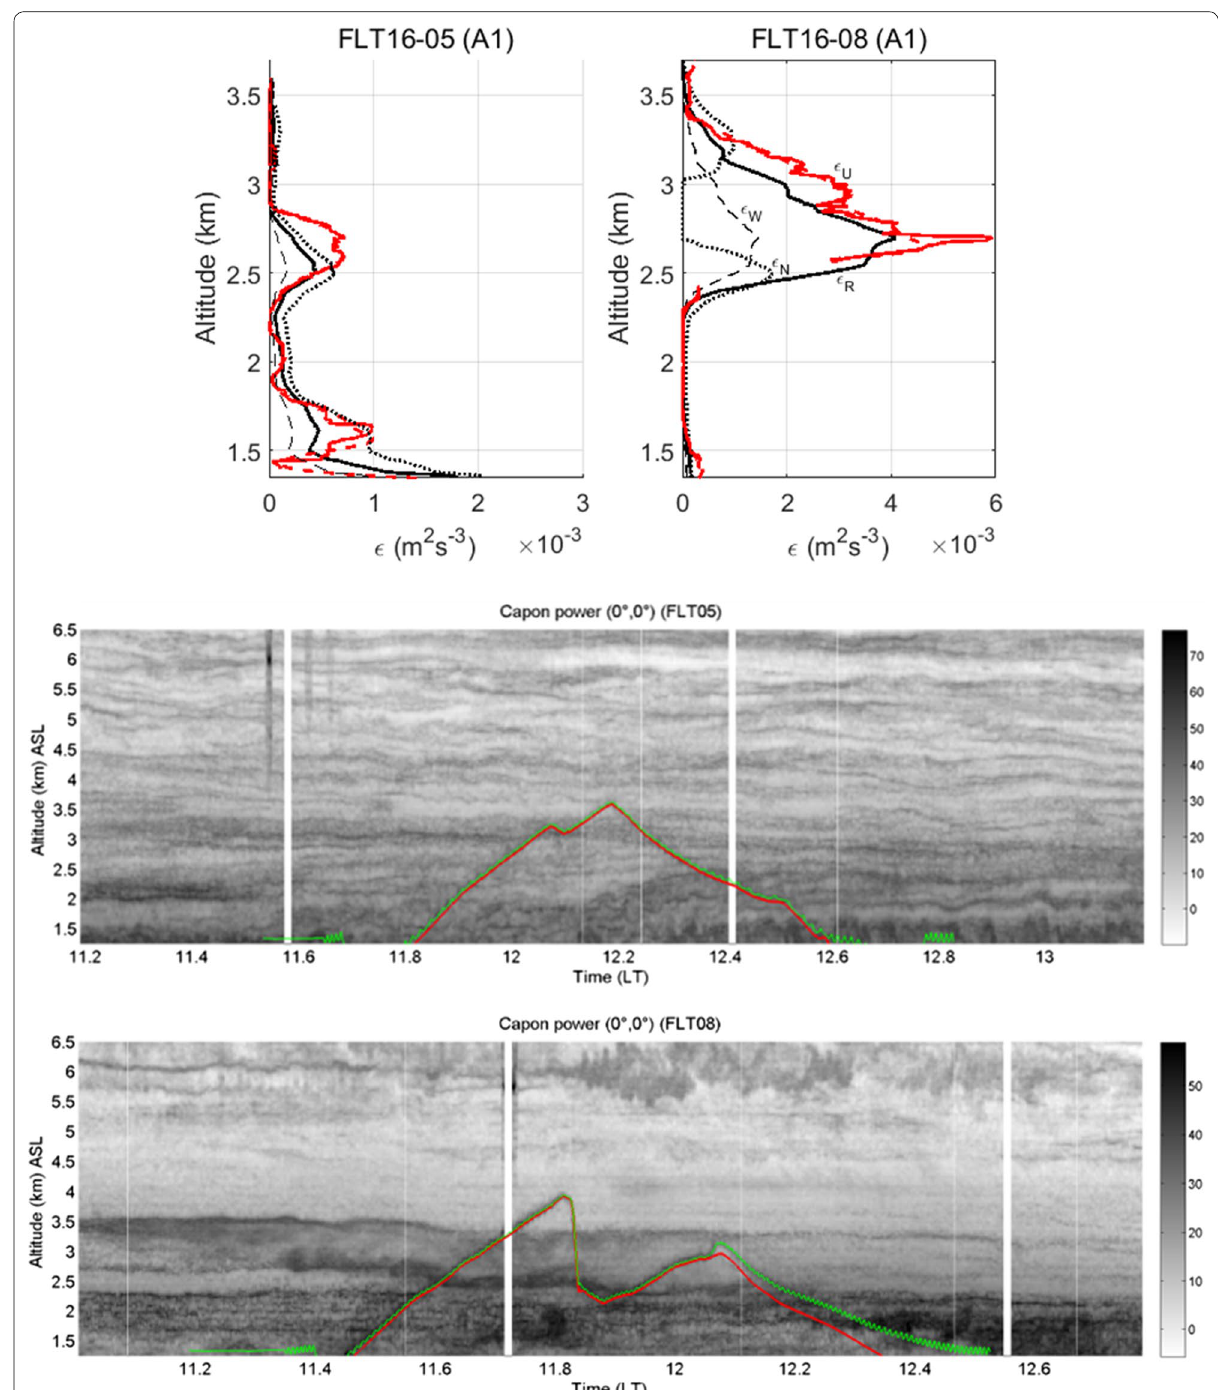
Fig. 12 (Top) Pseudo-vertical profiles of ε U , ε R , ε N and ε W for FLT16-05 (A1) and FLT16-08 (A1). For legibility, the standard deviation for the radar has been omitted. (Bottom) Time-height cross sections of radar echo power at vertical incidence around the two UAV flights. The green (red) lines show the distance (altitude) of the UAV with respect to the MU